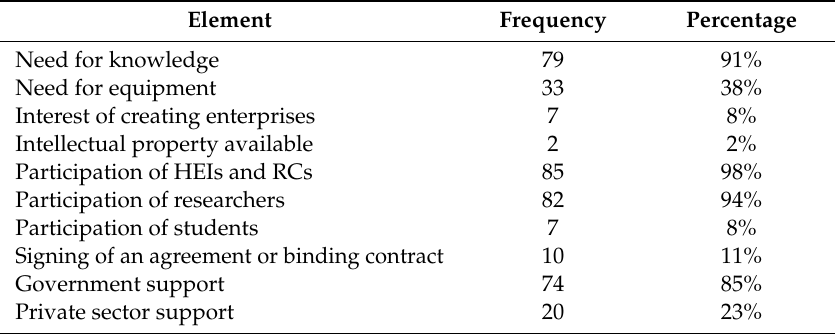
Table 3. Important elements that appear in the TKT processes of the 87 cases analyzed.